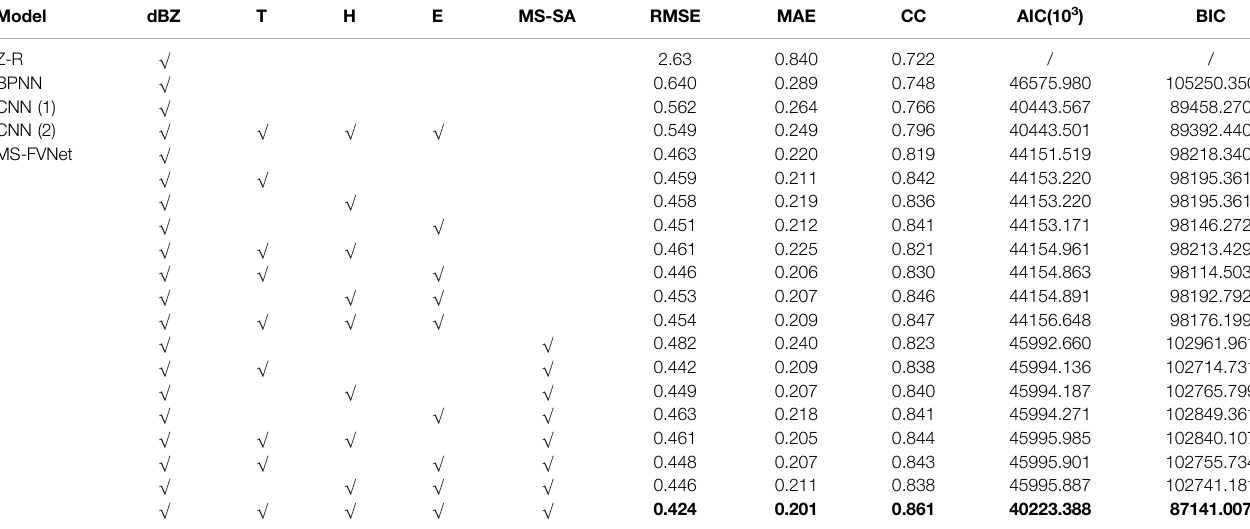
TABLE 1 | The scores of Z-R, BPNN, CNN (1), CNN (2) and MS-FCVNet under evaluation metrics RMSE, MAE, CC at the 6-minute scale and information criteria AIC, BIC. The bold text is the optimal level of the evaluation index.